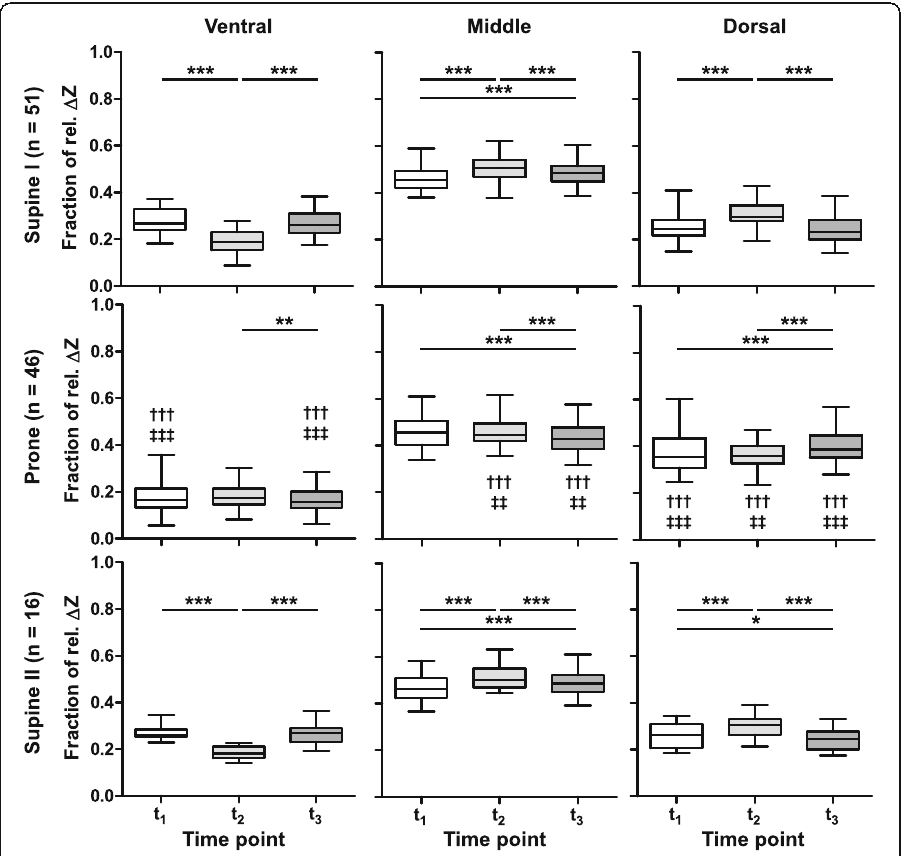
Fig. 4 Fractional bioimpedance change in ventral, middle and dorsal regions-of-interest. The fractional changes are given at three time points during the bronchoalveolar lavage procedure: after the disconnection of the endotracheal tube from the ventilator before the lavage fluid instillation ( t 1 ), after the fluid instillation ( t 2 ) and after the fluid suction before the resumption of ventilation ( t 3 ). The data was obtained first in supine (top row), then prone (middle row) and supine (bottom row) animals (supine I, prone and supine II, respectively). The significance of differences between the individual time points was derived from post analyses at * p <0.05, ** p <0.01 and *** p <0.001. Significantly different values from the supine I position at corresponding time points are given as ††† p <0.001 and from supine II position as ‡‡ p <0.01 and ‡‡‡ p